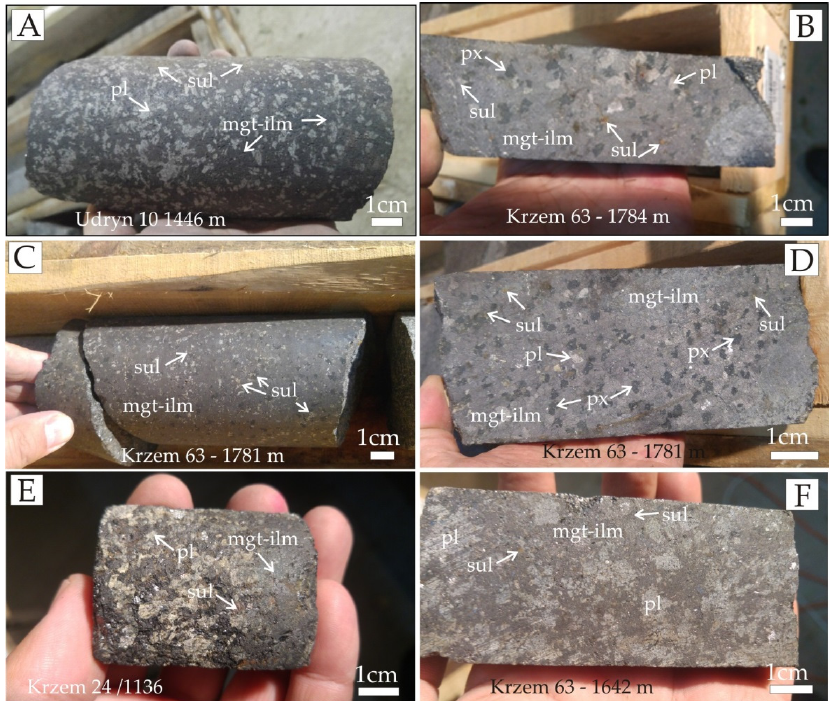
Figure 6. Typical massive and semi-massive magnetite-ilmenite (mgt-ilm) ores hosted by anorthosite or norite from the Udryn ( A ) and Krzemianka ( B – F ) deposits. Note: Krzem 63–Krzemianka 63 bore- hole, 1784 m—an approximate depth of sampling. Abbreviations: mgt-ilm—magnetite-ilmenite; pl—plagioclase; px—pyroxene; sul—sulphides. The main ore minerals were magnetite and ilmenite, which constituted more than Table 2. The basic statistical parameters of the chemical composition of magnetite, ilmenite, and Al-spinels from the Krzemianka and Udryn Fe-Ti-V deposits in such as pyrite, siegenite, millerite, bravoite, cubanite, galena, sphalerite, and rare inclu- sions of greenockite, talnakhite, hessite, or native bismuth were identified.